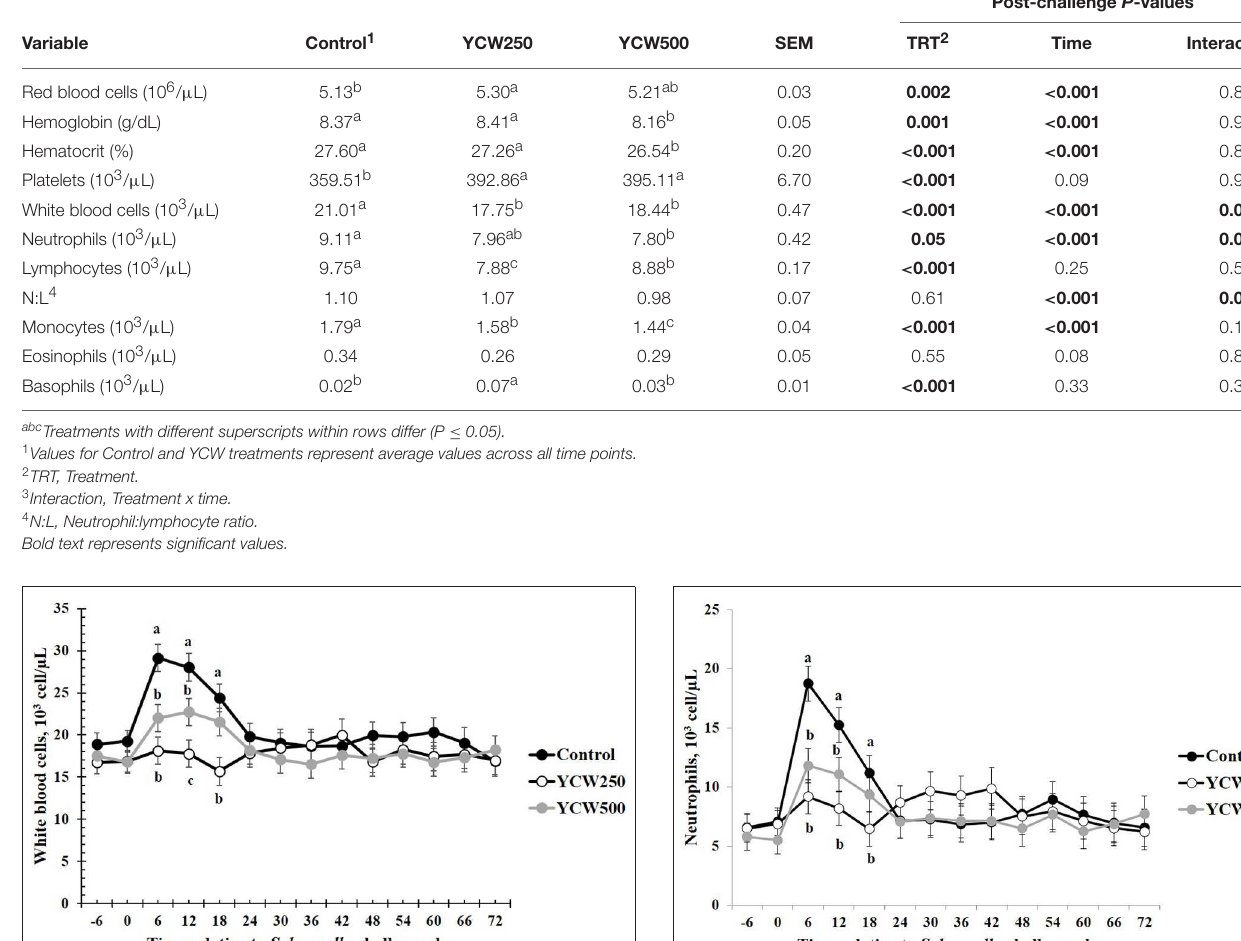
Post-challenge P -values